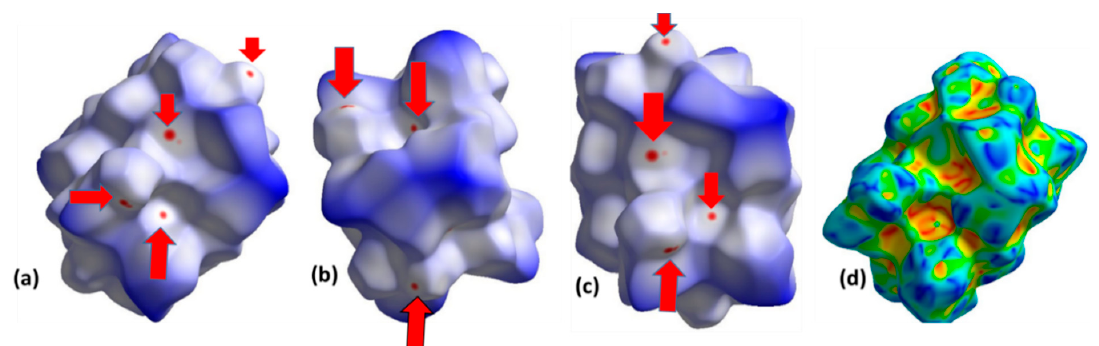
Figure 3. HSA-mapped ( a – c ) d norm and ( d ) shape index.